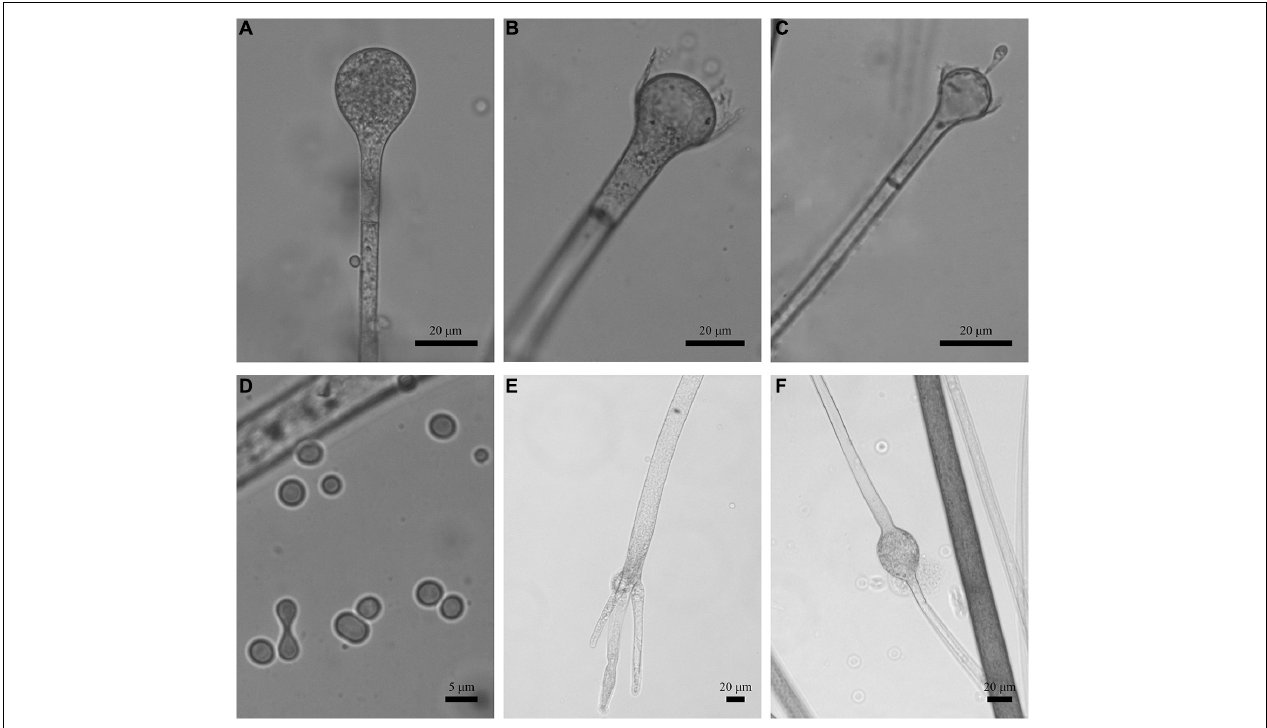
FIGURE 8 | Morphologies of Absidia turgida CGMCC 3.16032. (A) Sporangium; (B,C) columellae; (D) sporangiospores; (E) rhizoids; (F) swollen on hyphae. Scale bars: (A–C,E,F) 20 µ m; (D) 5 µ m.